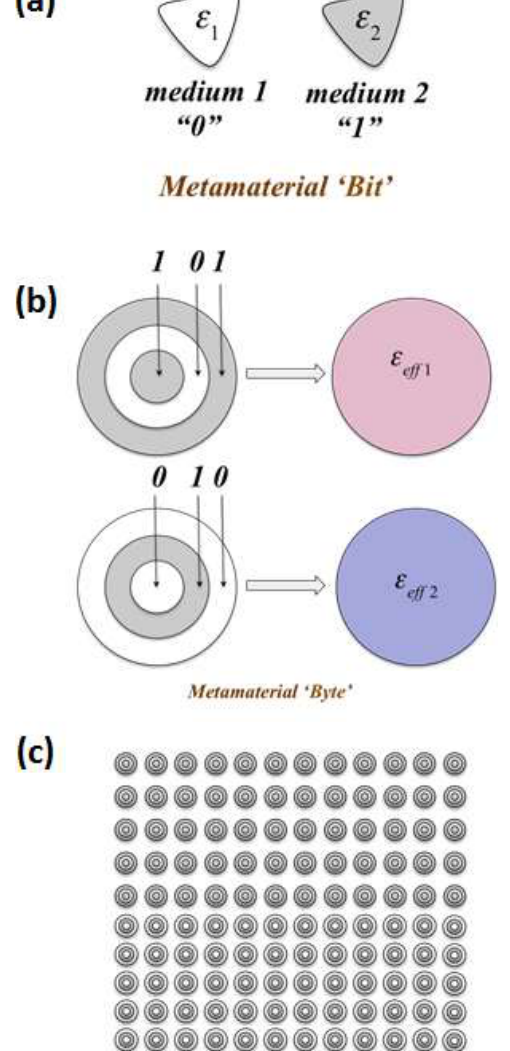
Figure 10: Sketch of notion of “digital’ metamaterials: (a) Selection of two elemental building material blocks as ‘bits’ with the follow- ing condition: Real parts of the permittivity values of the two bits, ϵ ϵ 1 and 2 , should have opposite signs. (b) By combining the bits one can construct different material ‘bytes’ with differing effective permittivity values as viewed by an outside observer. (c) Material ‘bytes’ can be used to construct larger structures, e.g., layers of core-shell bytes with different orders of ‘bits’, i.e., “1 0 1” bits and “0 1 0” bits.